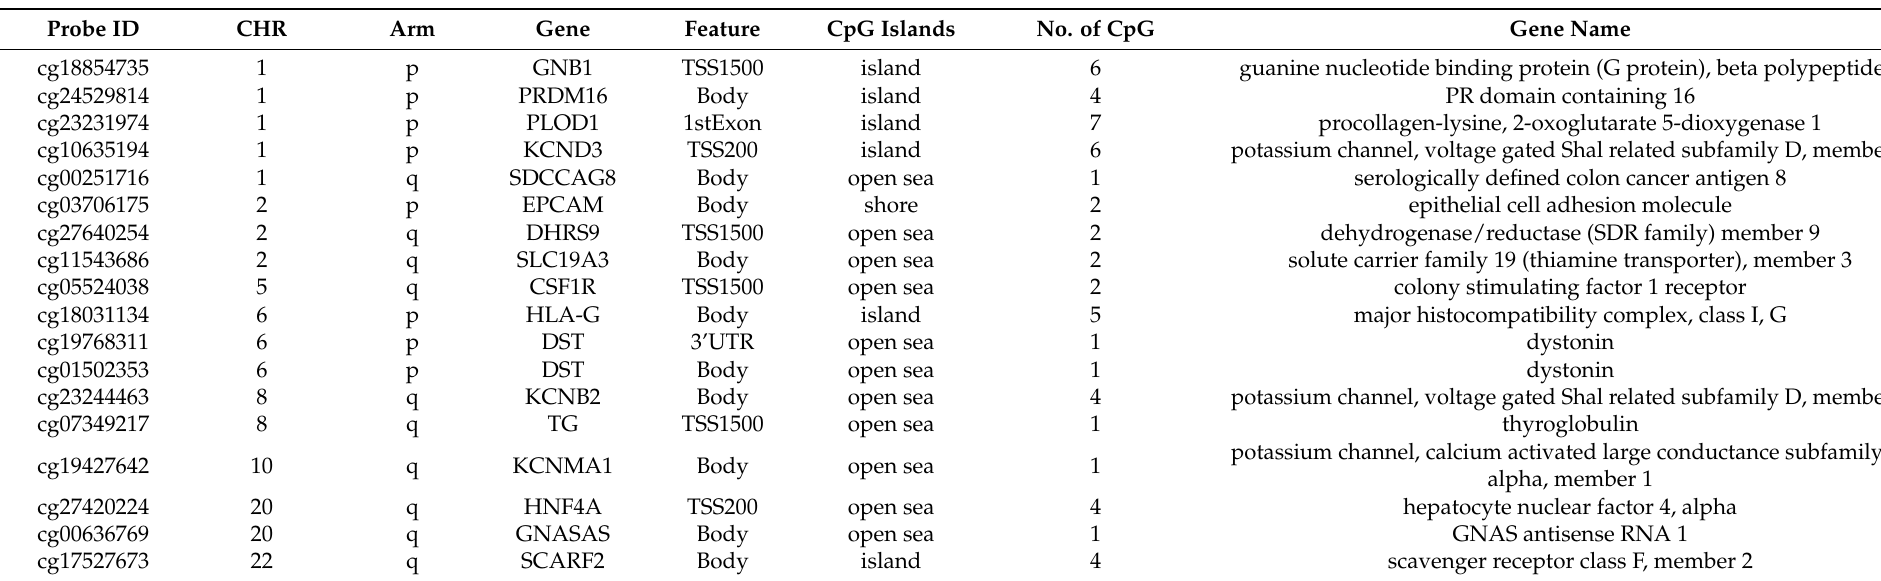
Table 2. 18 CpG sites related with developmental disorder, skeletal and muscular disorders, skeletal and muscular system development, metabolic disease, and lipid metabolism. Probe